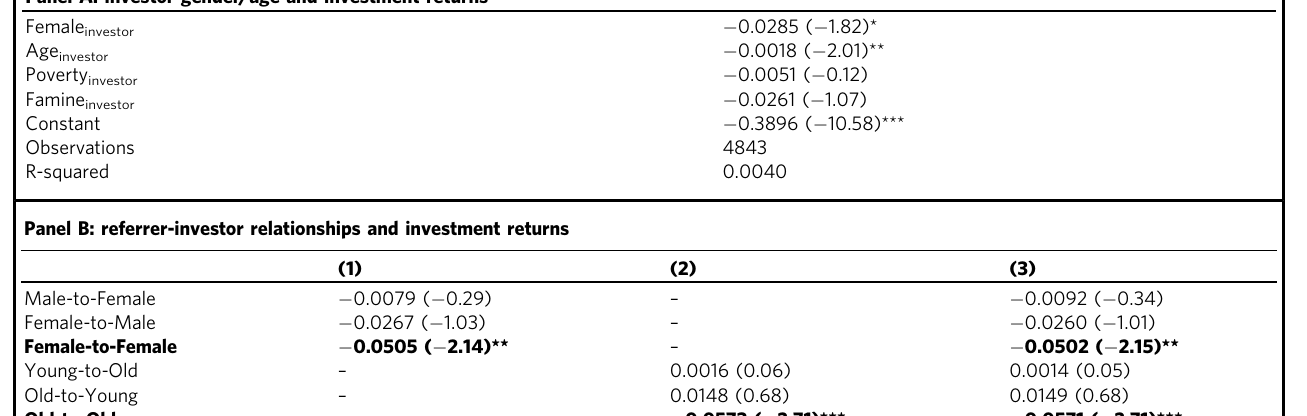
Table 5 Investor gender/age, referrer-investor relationships, and investment returns. Panel A: investor gender/age and investment